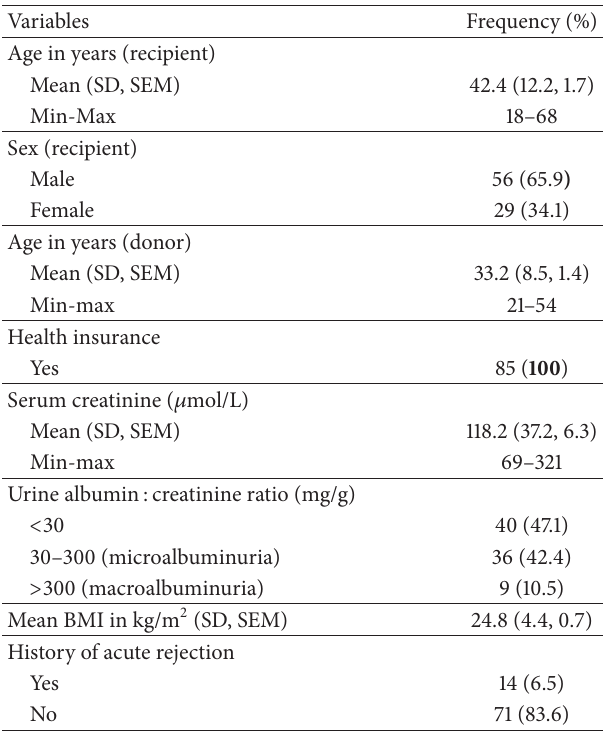
Table 1: Baseline